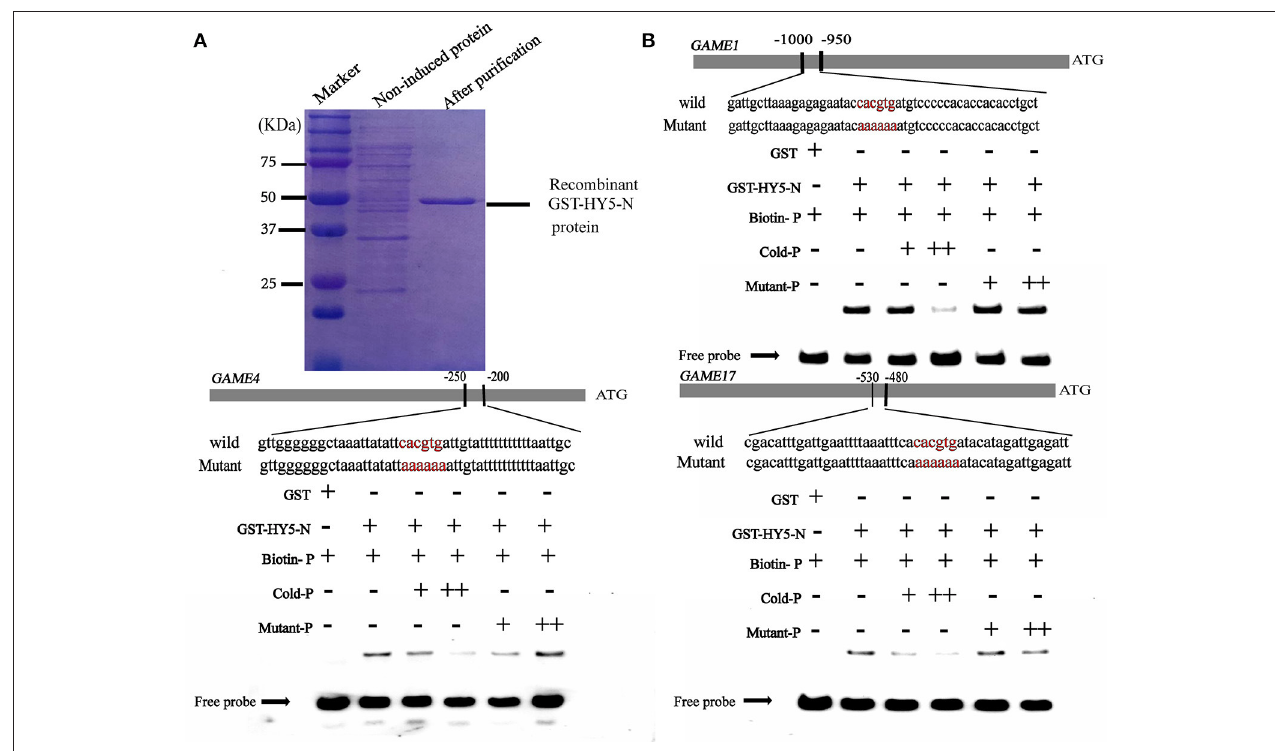
FIGURE 5 | Electrophoretic mobility shift assay (EMSA) showing the association of Sl HY5 with promoters of SGA biosynthetic genes SlGAME1 , SlGAME4, and SlGAME17 . (A) SDS–PAGE gel stained with Coomassie blue showing affinity purification of the recombinant Sl HY5 protein used for the EMSA. (B) Sl HY5 binds directly to the G-box (CACGTG) element of the promoters of SlGAME1 , SlGAME4 , and SlGAME17 . Biotin-labeled DNA probes for the promoters or mutated probes were incubated with GST-HY5 protein and the DNA-protein complexes were separated on 6% native polyacrylamide gels. + or ++ indicate increasing amounts of unlabeled probes as the